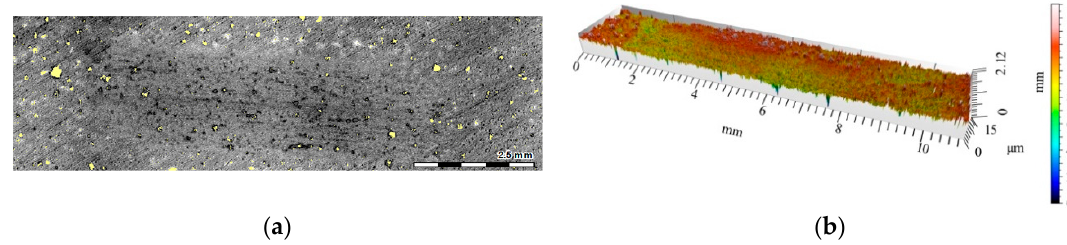
Figure 14. View of the wear track in the C3S7 hybrid composite layer after dry sliding: ( a ) Digital image; ( b ) Cross-section through 3D view.